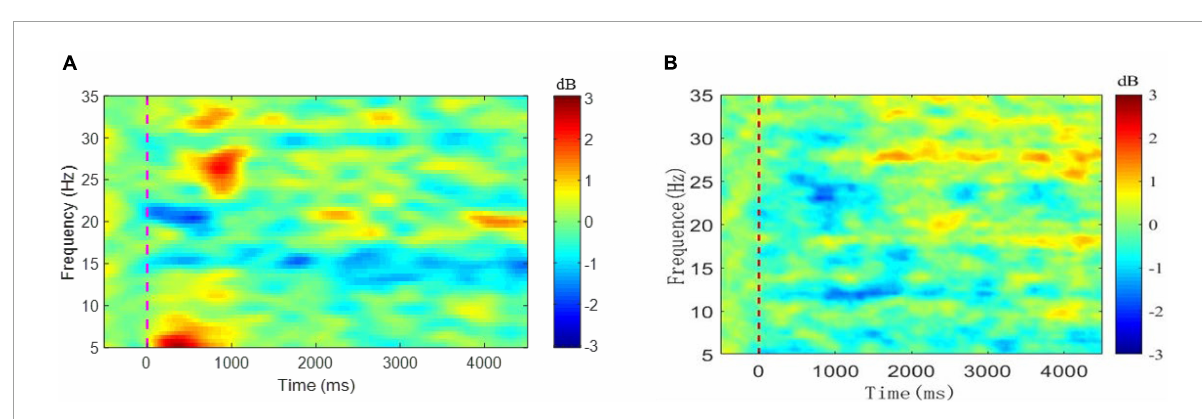
FIGURE4 Mean of nERSP at Cz for (A) 8 patients and (B) 6 healthy control